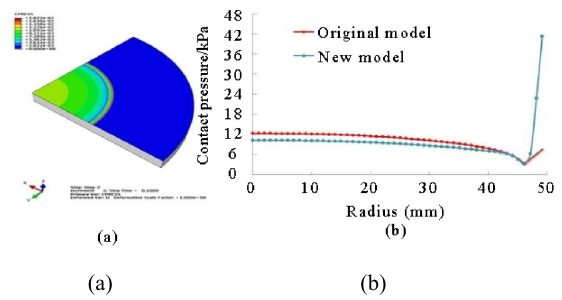
Fig. 6 Nominal contact pressure P distribution: (a) 3D P contour for new model and (b) P distribution along workpieceradius for both old and new models.